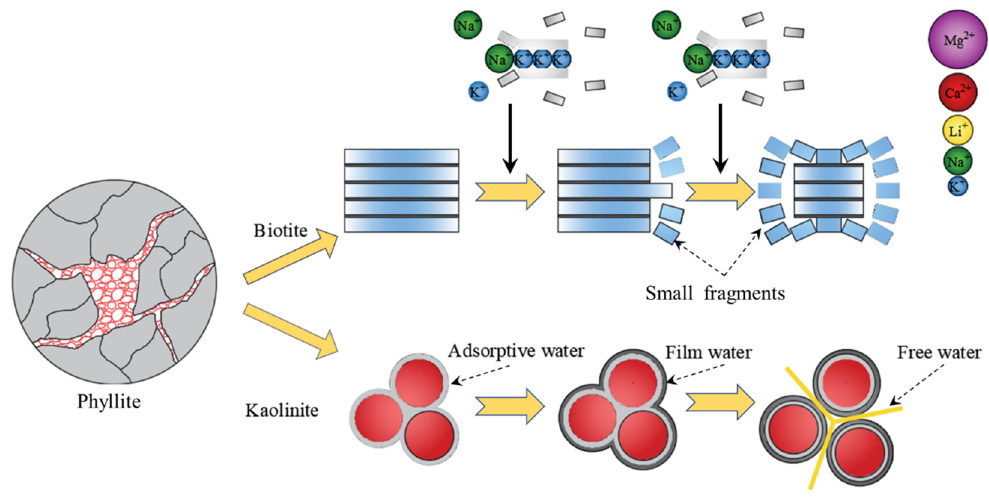
Figure 17. Diagram of the influence of water on phyllite